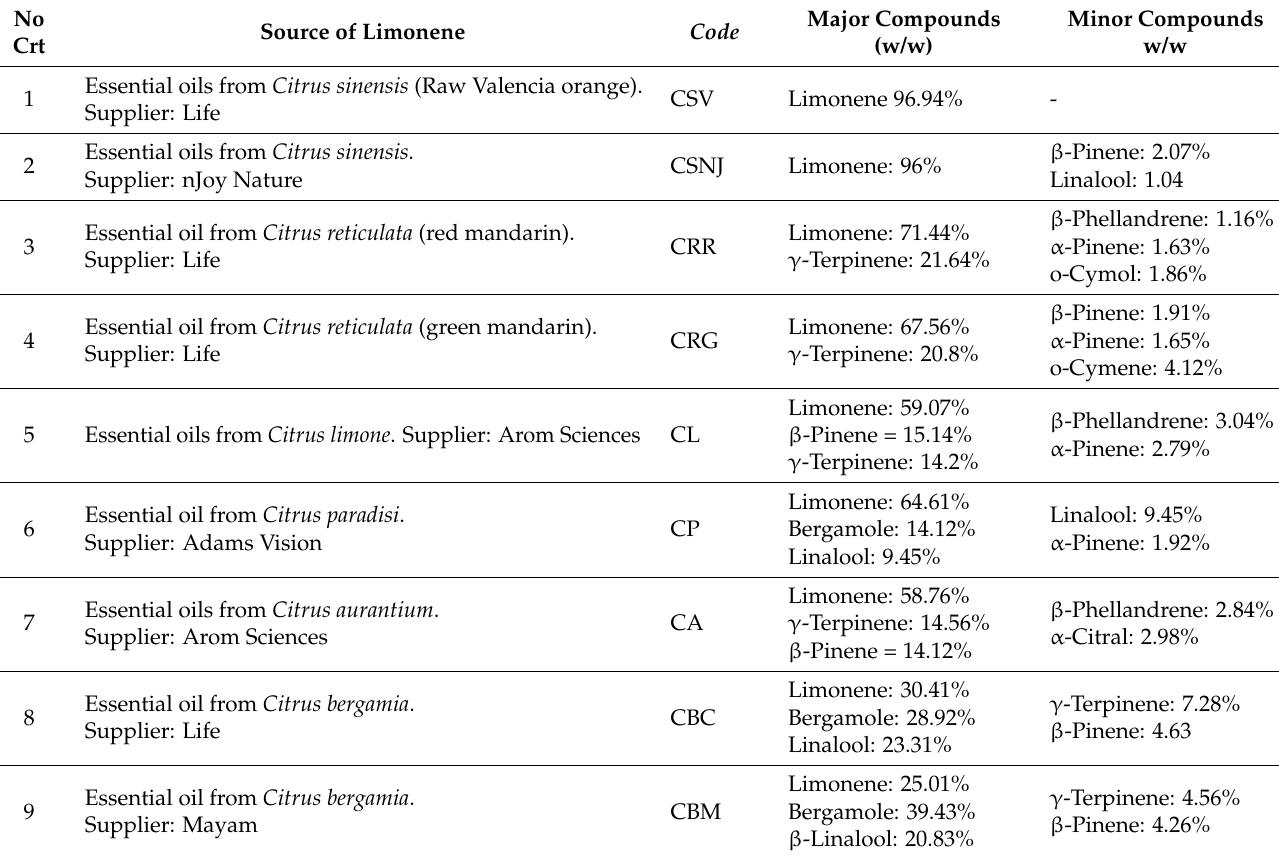
Table 1. Natural source of limonene used to validate antimicrobial